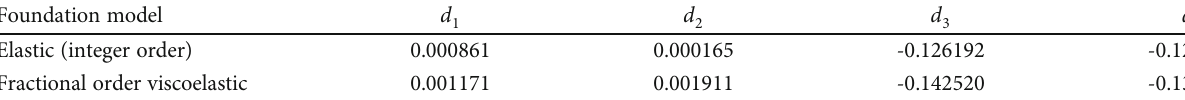
Table 2: Parameters of fractional viscoelastic foundation beam.